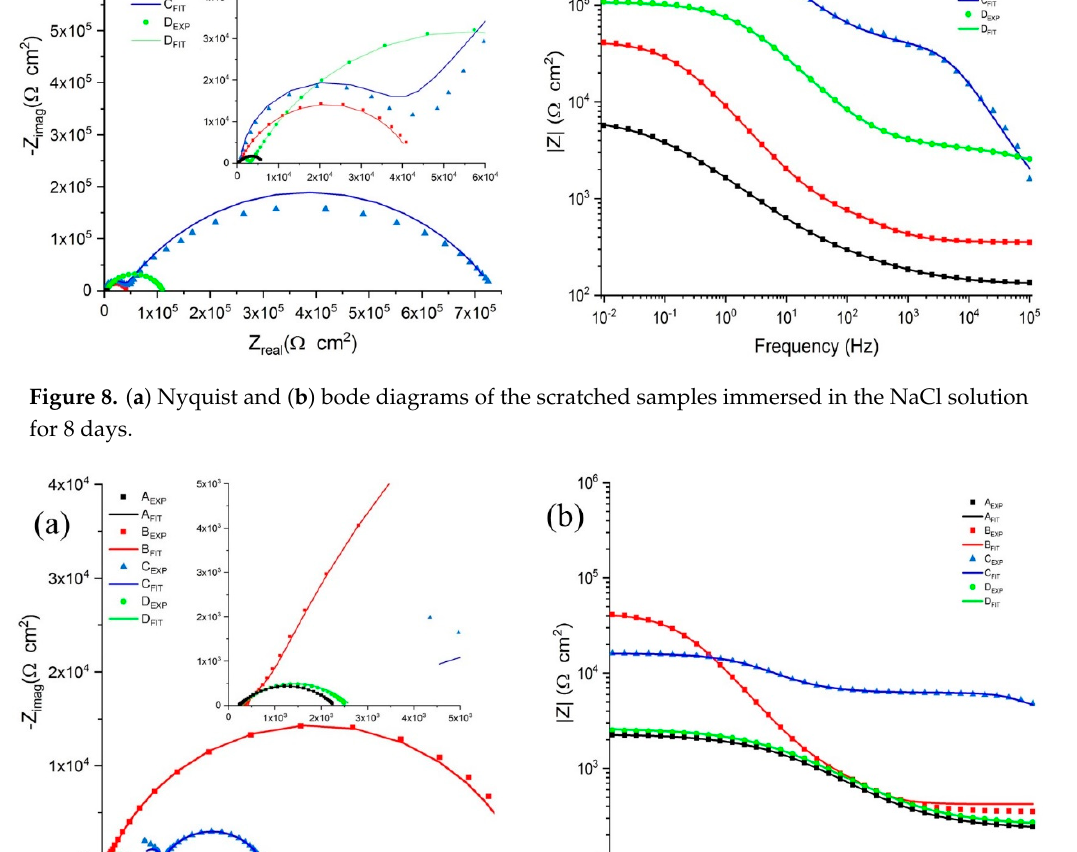
Figure 10. Employed electrical equivalent circuit for the fitting of the Nyquist and bode curves. Table 3. Electrochemical impedance spectroscopy ( EIS) parameters for the scratched coatings and immersed in the 3.5 wt.% NaCl. Sample Code